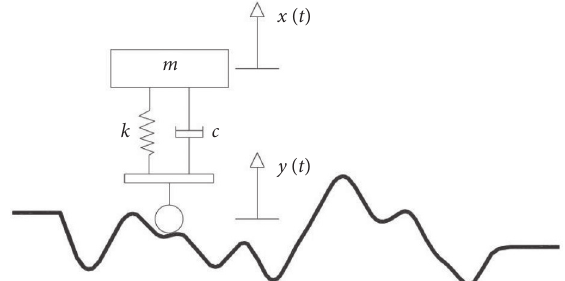
Figure 1: SDOF model of the